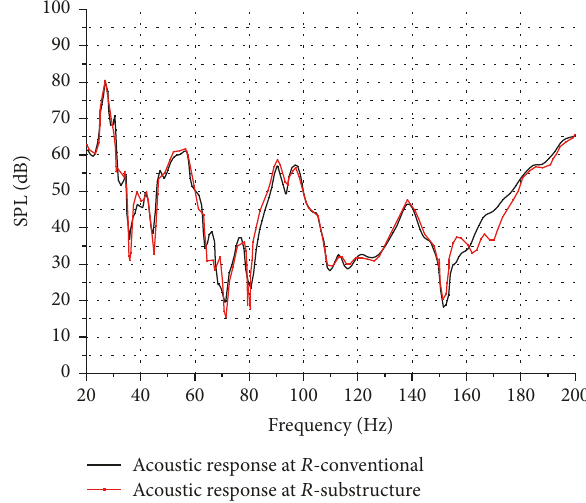
Figure 5: Acoustic characteristic at point 𝑅